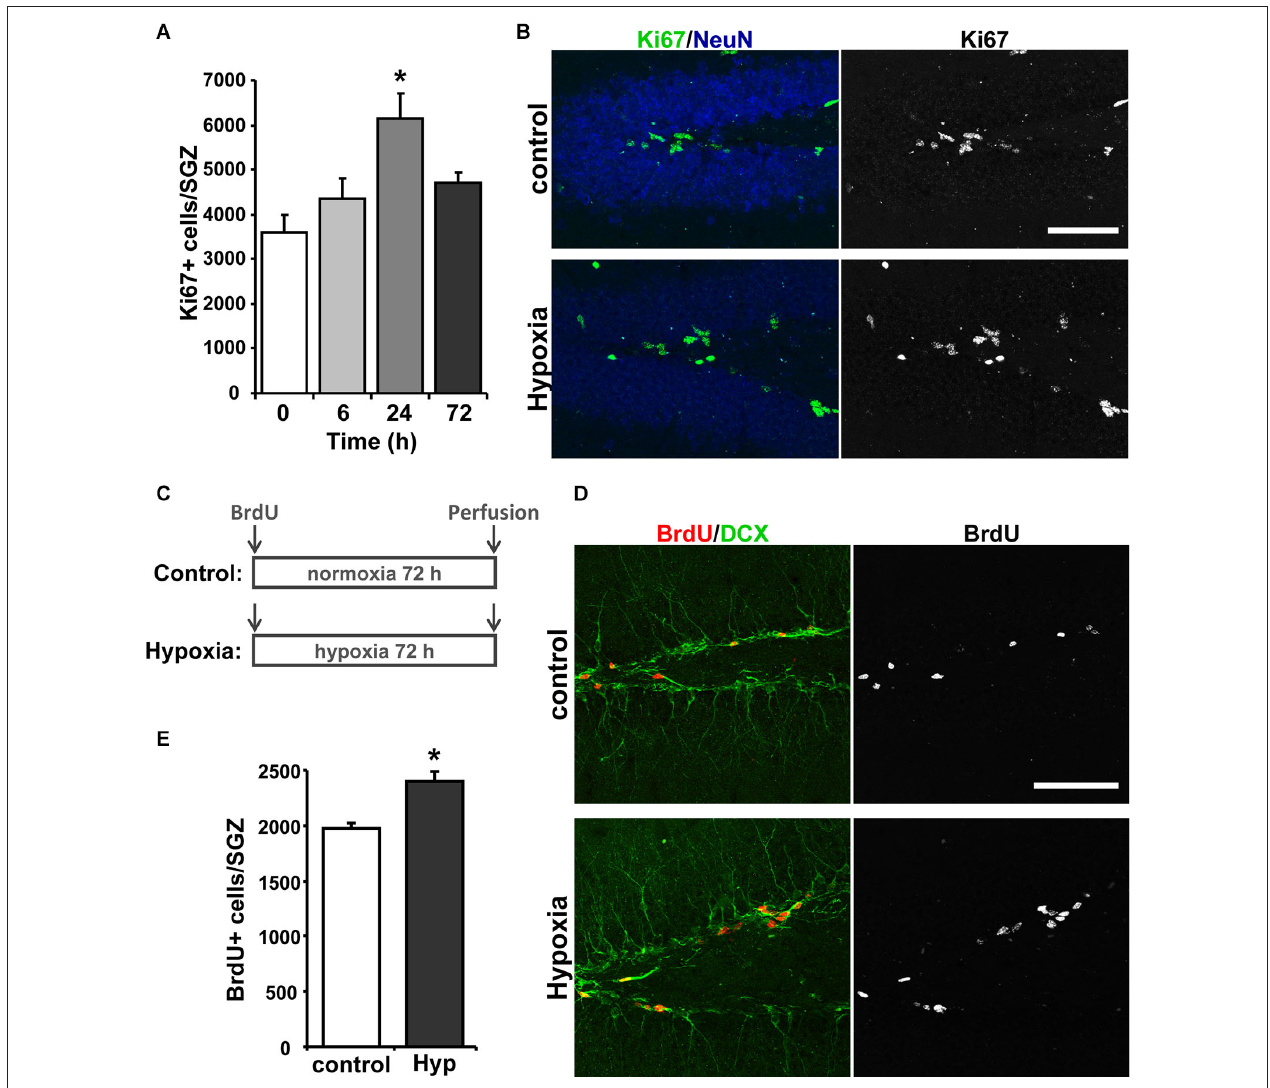
kg − 1 BrdU and were then exposed for 72 h to normoxia or hypoxia, respectively, after which were then immediately transcardially perfused. (D) Representative double labeling of BrdU and DCX in the hippocampus of control mice and mice exposed to hypoxia for 72 h. Scale bar: 50 µ m. (E) Quantification of total number of BrdU + cells in the SGZ of control mice and mice exposed to hypoxia for 72 h. Bars represent mean ± S.E ( n ≥ 3 mice). * p <